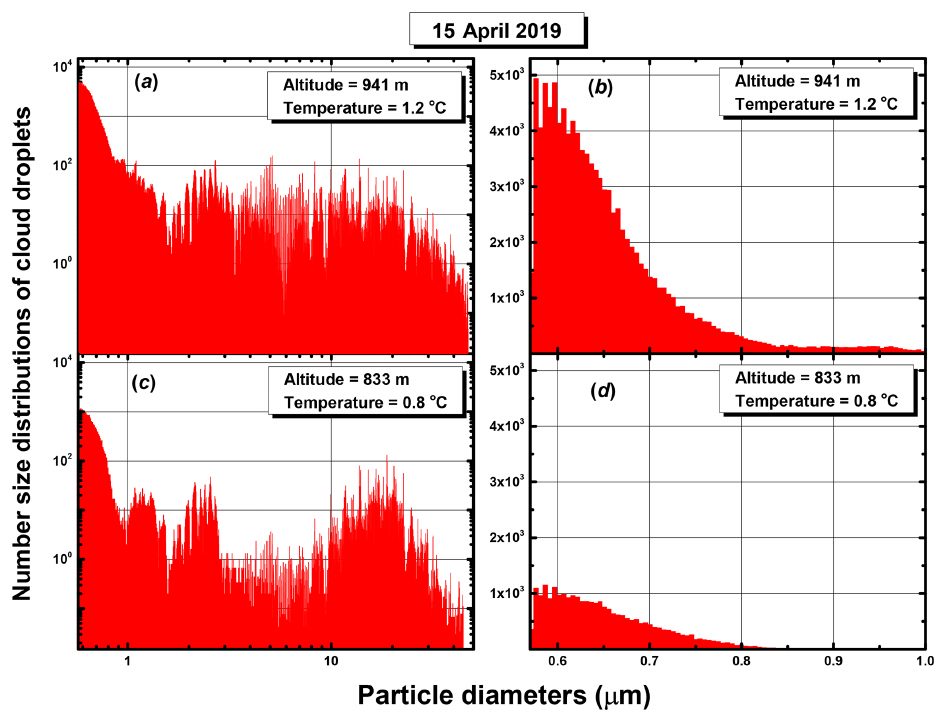
Figure 12. Detailed size distributions obtained with the standard pure water FWSCS from two PbP files of different flight lines performed on 15 April 2109, through the same liquid cloud over southern Romania. Panels (a) and (b) correspond to the higher altitude, while panels and (c) and (d) show results for the lower altitude. Panels (b) and (d) focus on the sub-micrometer details of the full size distributions plotted in panels (a) and (c)